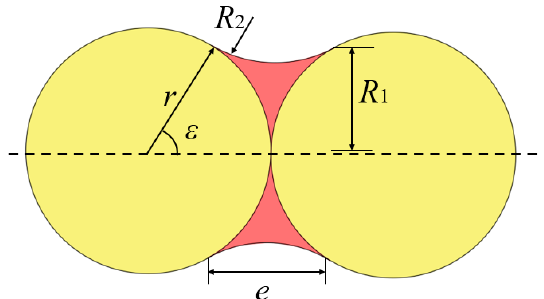
Figure 3. A model of black soldier fly feces binding into spheres.